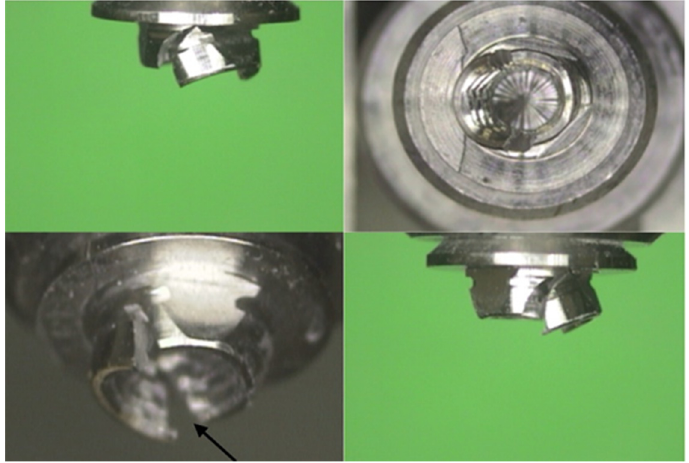
Figure 2. Specimen number seven in group A shows deformation and fracturing within the cone of the multi-unit abutment (MUA) under an applied load of 350 N. This mode of failure was predominant in group